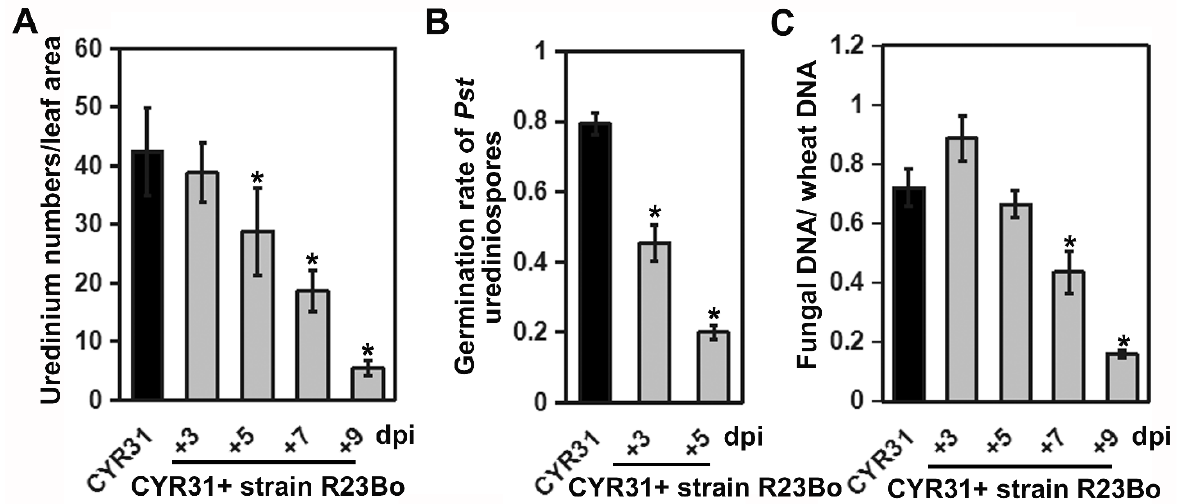
Figure 5. The Cladosporium cladosporioides isolate hyperparasitizing Puccinia striiofrmis f. sp. tritici (Pst ). ( A ), Wheat leaf inoculated only with the conidian suspension of C. cladosporioides isolate R23Bo; ( B ), At 12 days post inoculation (dpi), wheat leaves inoculated only with Pst urediospores; ( C – F ), Inoculations with the conidian suspension of C. cladosporioides after wheat leaves inoculated with Pst (pictures taken 12 dpi of Pst ). C – F are Pst -infected leaves inoculated with C. cladosporioides at 3, 5, 7 and 9 dpi of Pst , respectively.